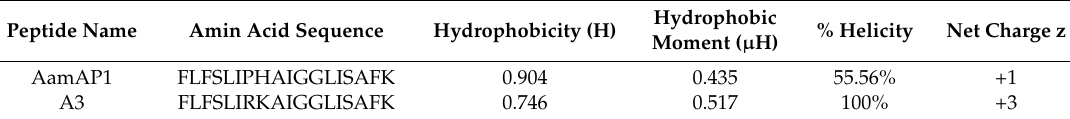
Table 1. Amino acid sequence and physico-chemical parameters of both AamAP1 and its synthetic analogue A3.